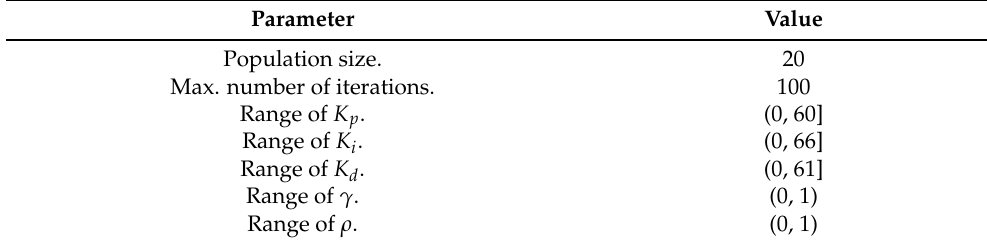
Table 1. Parameters of the PSO algorithm. Parameter Value Population size. 20 Max. number of iterations. 100 Range of K p .